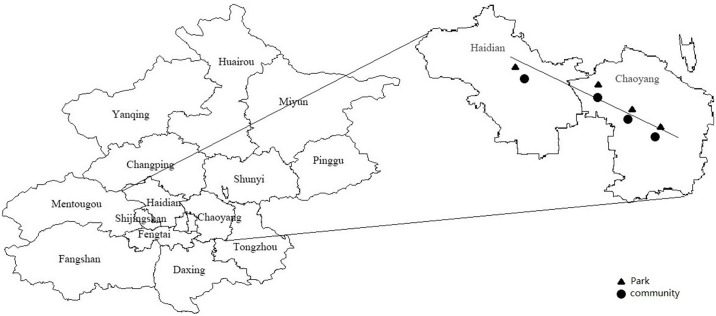
Location of the sampling sites in Beijing.The left panel shows the map of Beijing; Haidian and Chaoyang Provinces in the downtown areas are enlarged. The sampling sites are marked in the downtown areas along the monsoon line from Northwest to Southeast. These sites include 4 communities and 4 parks. The 4 communities are as follows: west campus of China Agricultural University (C1), Chinese Academy of Sciences (C2), Beijing University of Chemical Technology (C3), and King Stone Apartment (C4); the 4 parks are as follows: Medicinal Plant Development (P1), Olympic Forest Park (P2), Yuan Dynasty City Wall Relics Park (P3), and Chaoyang Park (P4).